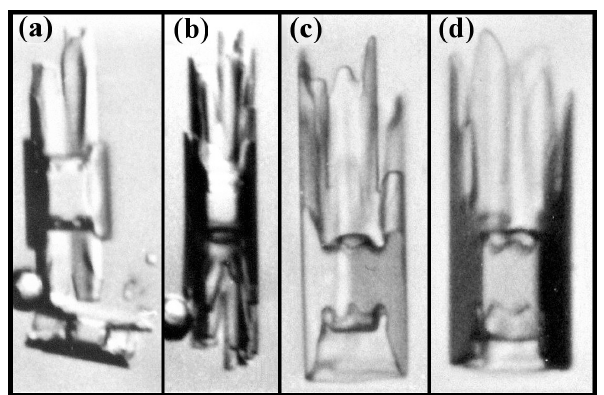
Figure B7. Initial sheath protrusions sprouted from droxtals of ∼ 40–70µm diameters at − 4 . 8 ◦ C (a, b) and − 5 . 9 ◦ C (c, d) and liquid- water saturation. (From the cloud chamber, courtesy of Akira Ya-